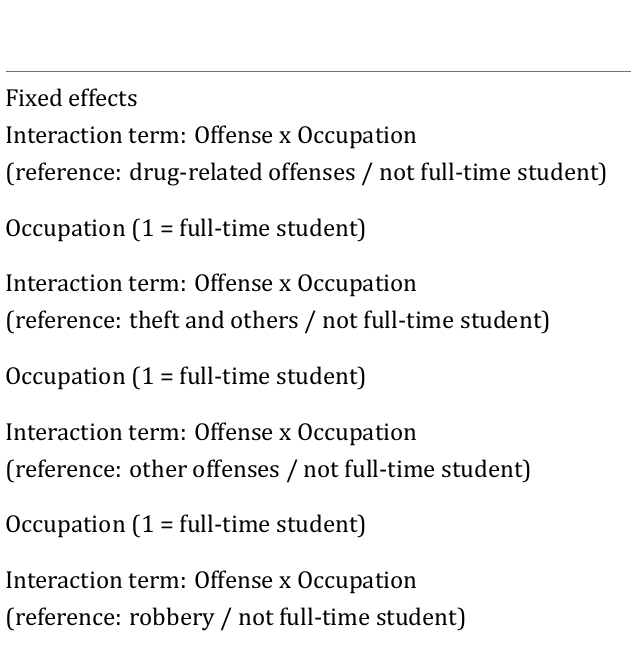
Table 3: Impact of the seriousness of the offense on con(cid:976)inement among full-time and non-full-time